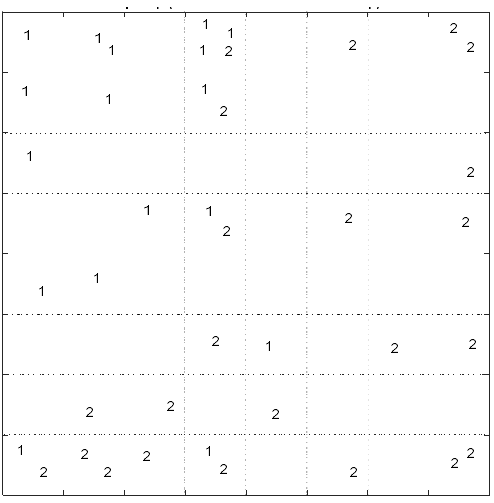
Figure 20. The Top-Map of SOM labeled with low (1) high (2) binding